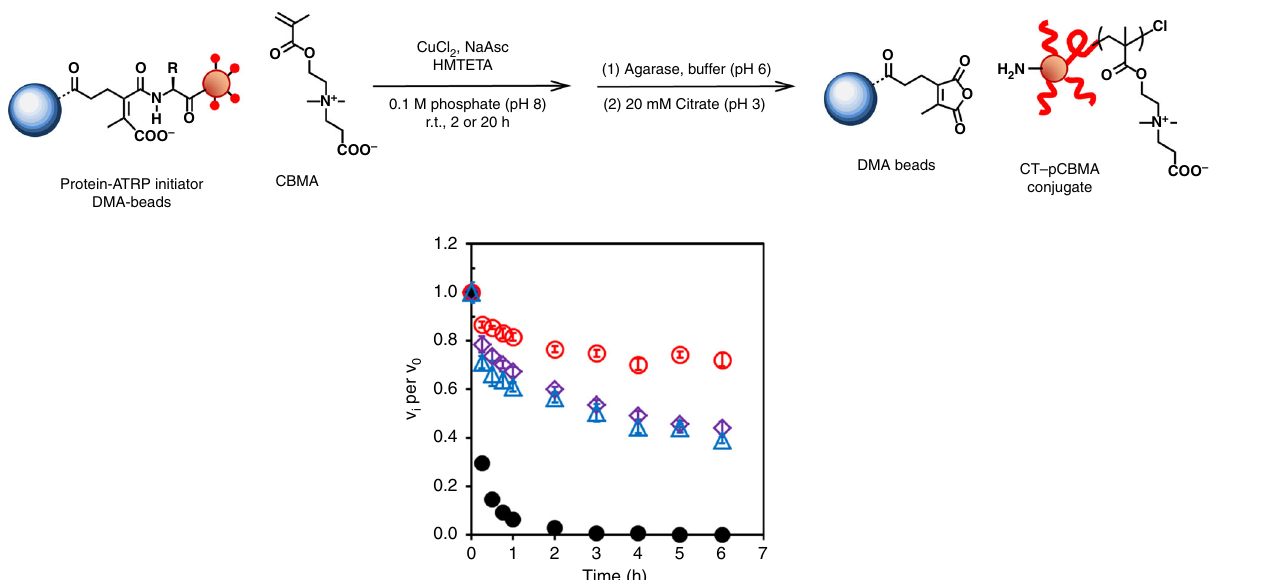
Fig. 3 Properties of released PARIS-synthesized protein – polymer conjugates. Irreversible inactivation of native CT and CT − pCBMA at 50 °C. CT − pCBMA immobilized at pH 6.0 and polymerized for 2 h (red open circle), CT − pCBMA immobilized at pH 8.0 and polymerized for 2 h (purple open diamond), CT − pCBMA by solution synthesis (blue open triangle), and native CT (black closed circle). Samples were incubated in 100 mM sodium phosphate buffer (pH 8.0, 50 °C) at 3.9 μ M CT and residual activity was measured over 6 h. All CT-pCBMA conjugates showed enhanced thermostability compared to native